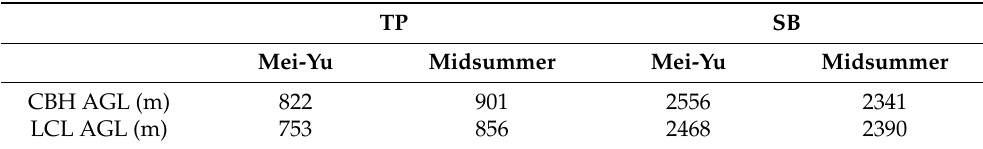
Table 2. Comparison of cloud base height (CBH) from ERA5 dataset and lifting condensation level (LCL) above ground level (AGL) during summer over the Tibetan Plateau (TP) and Sichuan Basin (SB). TP SB